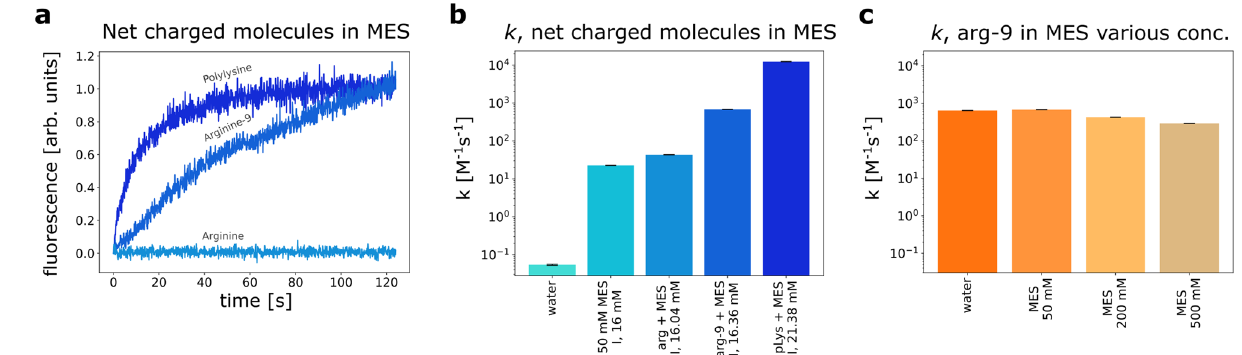
Fig. 3| Reactioninthepresenceofnet-chargedcatalysts.a CoA-M-CoAproduct formation in the presence of charged monomers, oligomers, and polymers, b and their k values.Theconcentrationofcatalystsisset,sotheconcentrationofpositive charges carried by them is equal to the concentration of negative charges on the